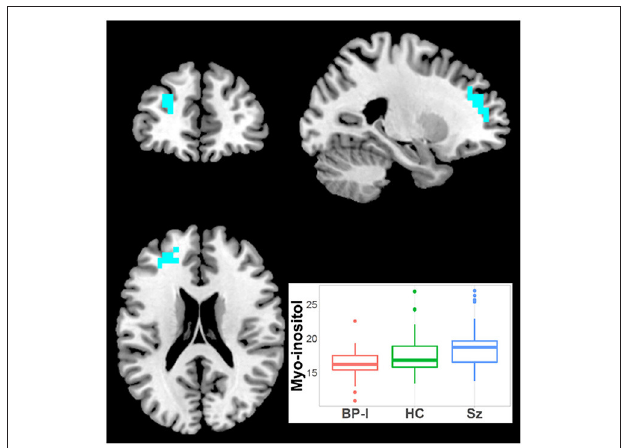
FIGURE 5 | Increased inositol in Schizophrenia (Sz) vs. Bipolar-I (BP) (healthy controls [HC] intermediate) in one cluster (19 voxels), CCLAV = 0.05, including the left superior frontal gyrus (65.7%) and the left middle frontal gyrus (23.1%). Boxplot shows weighted-average inositol cluster concentrations in institutional